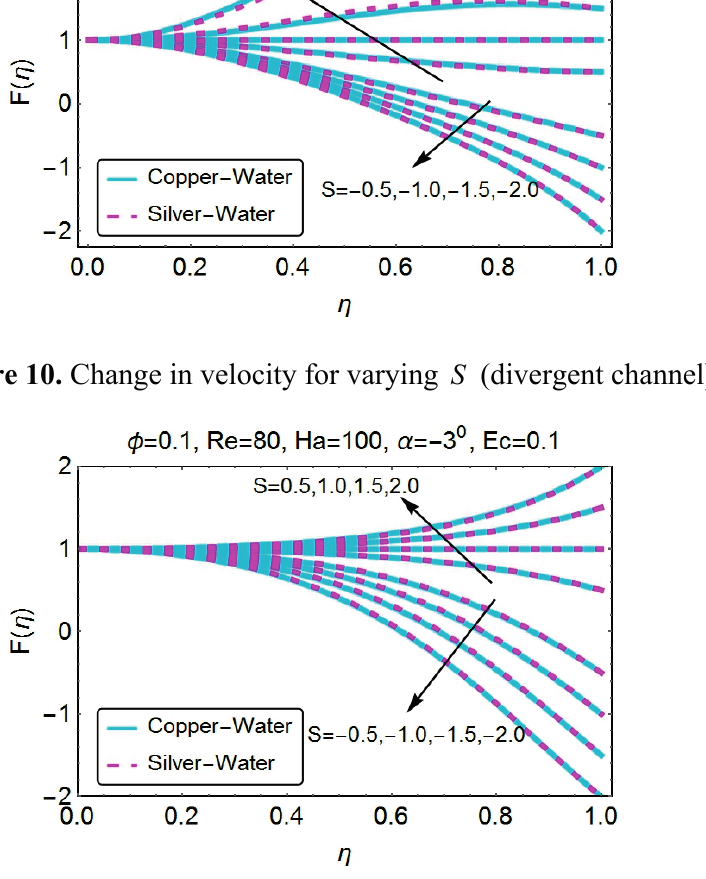
Figure 11. Change in velocity for varying S (convergent